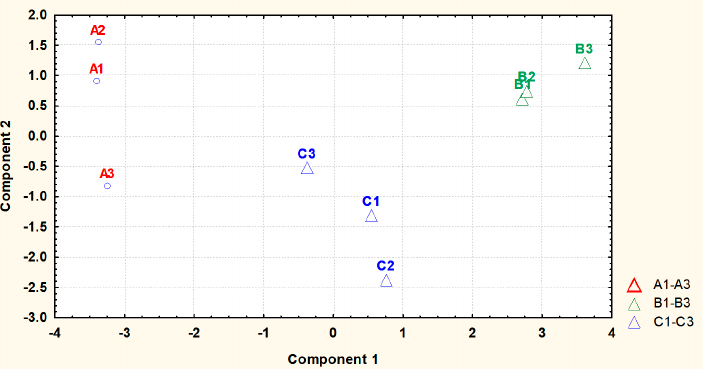
Fig. 6. Principal component analysis (PCA) scores (component1 versus component 2) plotted from cytoplasmic metabolite data of S. aureus harvested at stationary phase. The S. aureus cultures were grown under (A1-A4) ideal conditions at pH7_37°C (control), (B1-B4) pH6 at 35°C, and (C1-C4) pH8 at 35°C to stationary phase of growth before extraction of cytoplasmic metabolites and analysis by